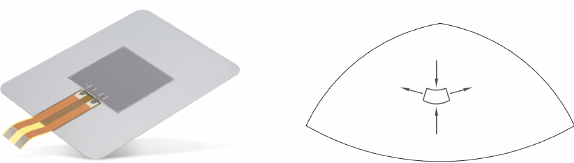
Figure 10: New thin piezo Haptic actuator (TDK courtesy) for flexural applications (left). Possible application point of the piezo-haptic actuator/sensor on a double curvature shell